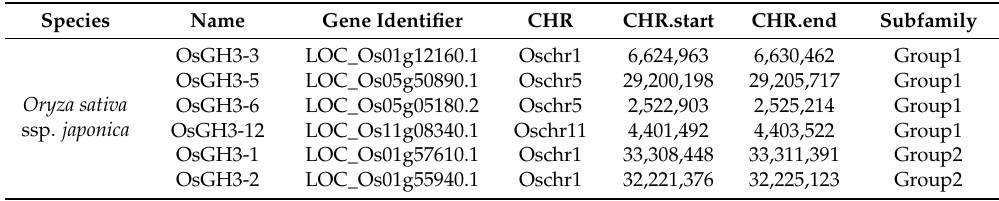
Table 1. GH3 genes identified in six Oryza